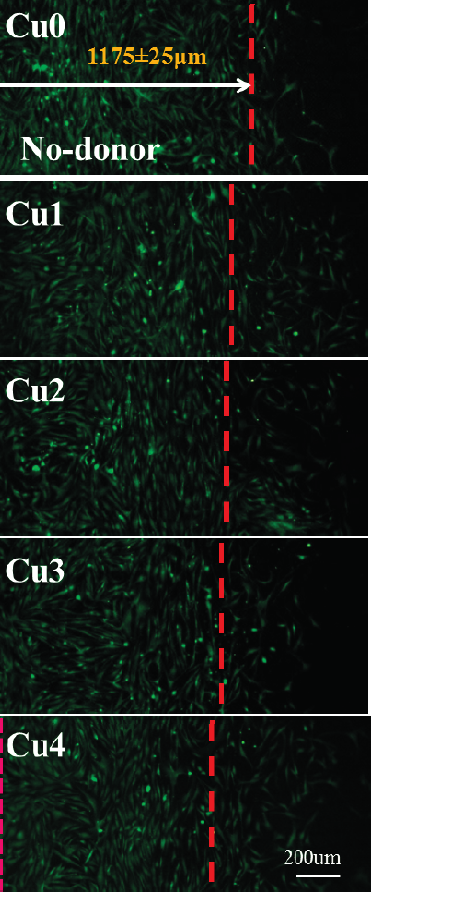
Figure 8. Migration of SMCs on the Cu0, Cu1, Cu2, Cu3 and Cu4 surfaces after culture of one day. The migration distance was calculated from at least 12